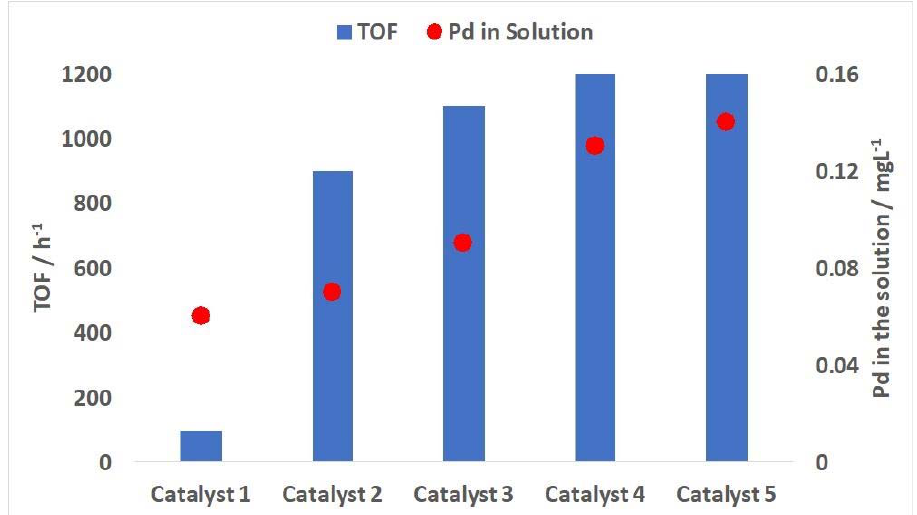
Figure 7. Turnover frequency (TOF) vs. Pd ‐ concentration in the solution (Pd leached). Catalyst 1: Ce 0.99 Pd 0.01 O 2 ‐δ , Catalyst 2: Ce 0.79 Sn 0.2 Pd 0.01 O 2 ‐δ , Catalyst 3: Ce 0.495 Sn 0.495 Pd 0.01 O 2 ‐δ , Catalyst 4: